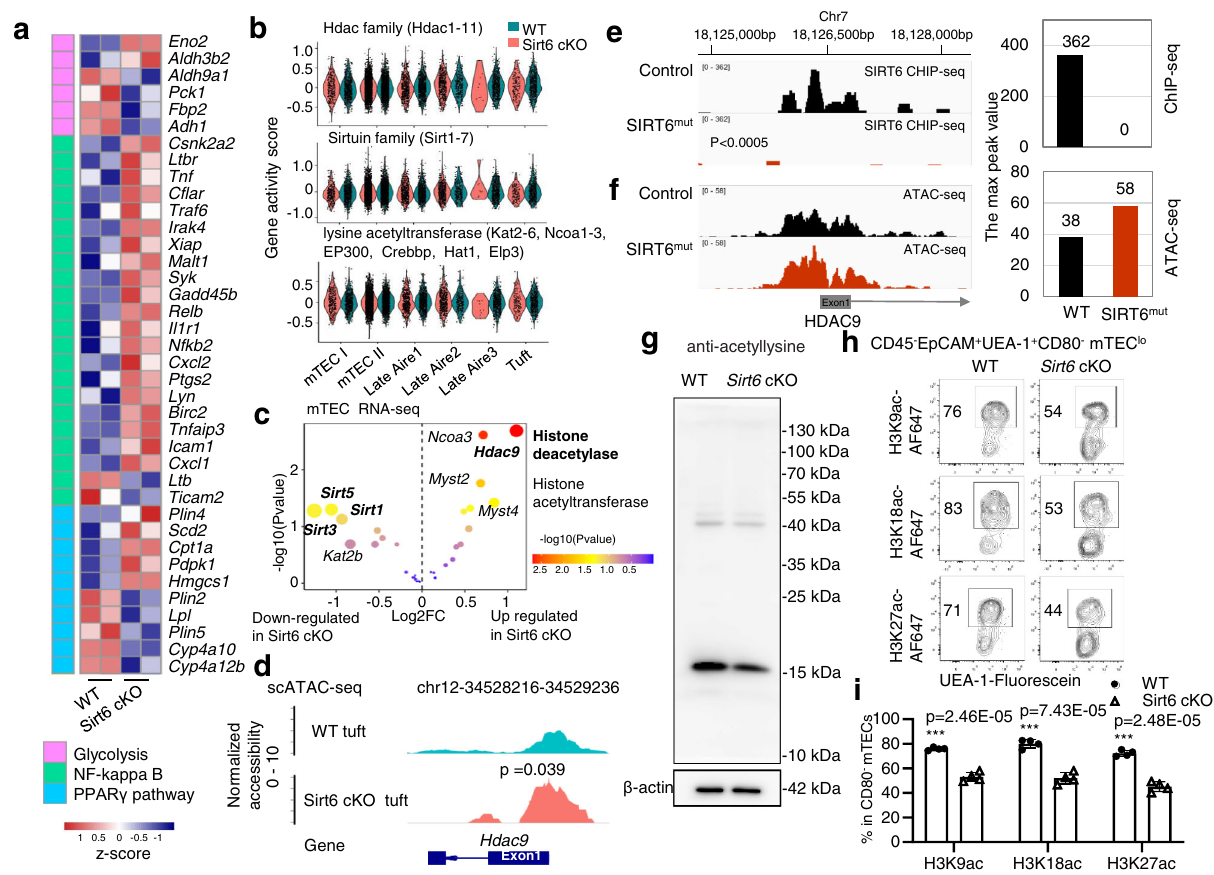
Fig. 6 Decreased chromatin accessibility of Pou2f3-regulated genes was consistent with the decreased acetylation regulated by the SIRT6-HDAC9 axis. a Glycolysis-, NF-kappaB pathway-, and PPAR γ pathway-associated genes were compared between WT and Sirt6 cKO mTEC bulk RNA-seq by heatmap. The color scale indicates the level of gene expression. b Gene set module scores of the histone deacetylase gene family, sirtuin gene family, and histone lysine acetyltransferase gene family were compared between WT (green) and Sirt6 cKO mouse (red) mTEC populations. c Differential expression of the histone deacetylase gene family, sirtuin gene family, and histone lysine acetyltransferase gene family was calculated by DEseq2 using WT and Sirt6 cKO mTEC bulk RNA-seq. The x-axis represents Log2FC, and the y-axis represents − log10 ( P value). The dot size is consistent with the |Log2FC| value. Histone deacetylase-related genes are labeled in bold, and histone acetyltransferase-related genes are not labeled in bold. d Chromatin accessibility peaks around the promoter of the Hdac9 gene between WT and Sirt6 cKO thymic tuft cells are shown in aggregated scATAC-seq tracks. The arrow indicates the length and direction of the peak around the promoter region of Hdac9 detected by scATAC-seq. e Capture of the UCSC (GRCh37/hg19) genome browser showing the human HDAC9 locus in ChIP-seq. f Capture of the UCSC (GRCh37/hg19) genome browser showing the human HDAC9 locus in ATAC-seq. g Western blot analysis of protein acetylation in mTECs (CD45 − CD326 + UEA-1 + Ly51 − ) isolated from wild-type or Sirt6 cKO mice. h Representative fl ow cytometric pro fi les of H3K9ac, H3K18ac, and H3K27ac expressed in CD80 − mTECs obtained from 4-week-old Sirt6 cKO mice and littermates. i Frequencies of H3K9ac, H3K18ac, and H3K27ac expression in CD80 − mTECs of 4-week-old Sirt6 cKO mice and littermates ( n = 4 per group). *** p < 0.001